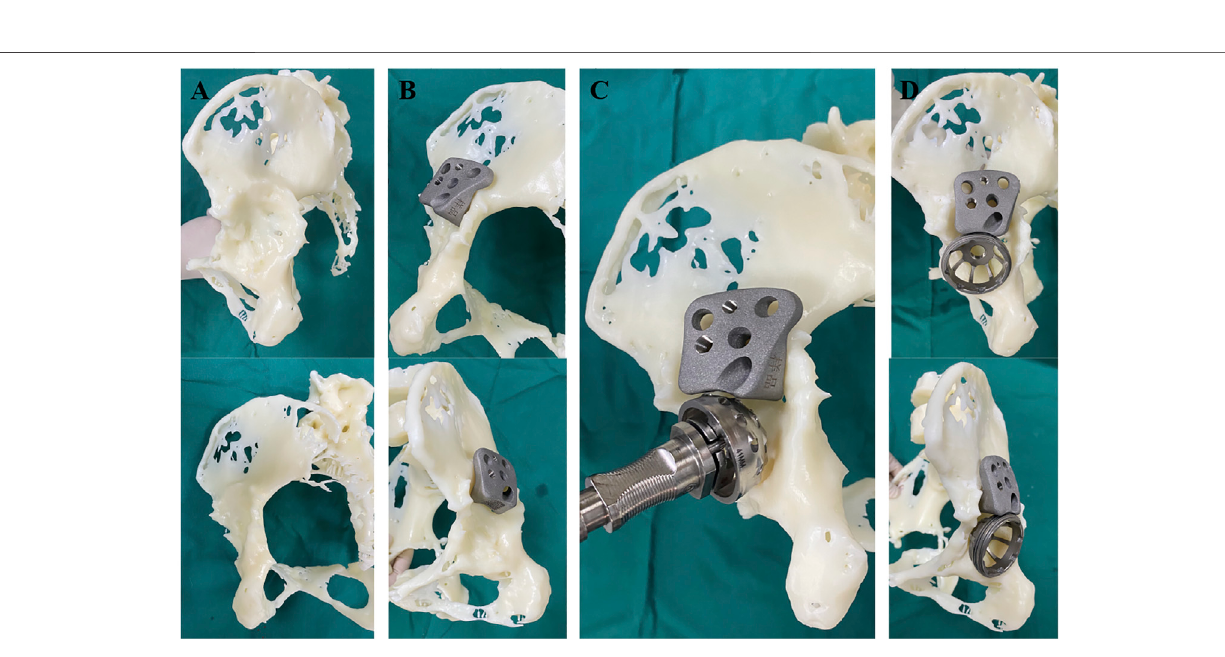
FIGURE2| Procedureofrapidprototype-assistedevaluation. (A) .Reconstructionofapatient ’ spelvicwithrapidprototype. (B) .3D-printedaugmentcouldachieve enough contact with host bone. (C) . Acetabulum was further fi led to host acetabular cup. (D) . Enough contact surface was achieved between cup, augment and host bone. Acetabular defect was fi lled with this combined